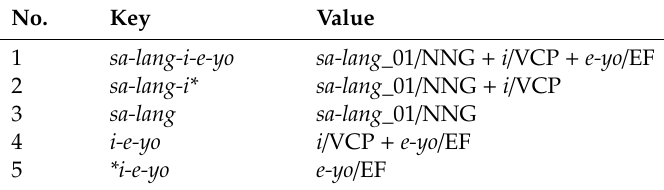
Table 2. Extricated pre-analysis partial eojeol dictionary (PPED) entries from the e ojeol “ sa-lang-i-e-yo ”. No.